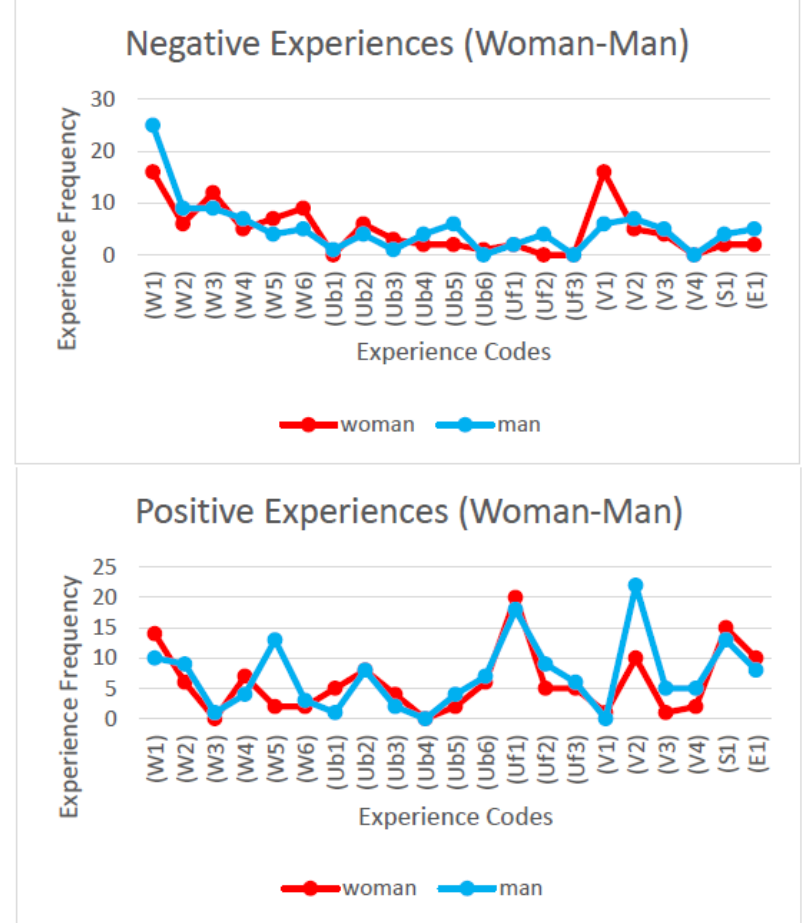
Figure 7. Comparison of positive and negative experiences by gender.